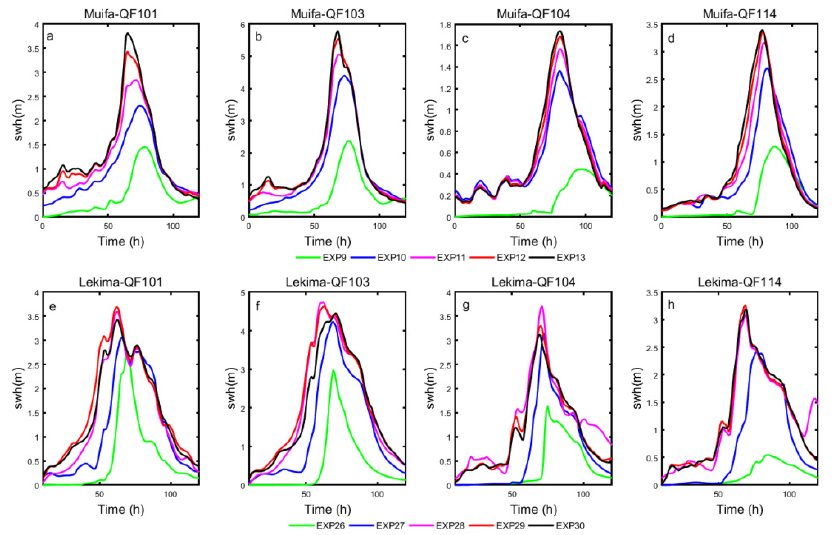
Figure 12. Significant wave height associated with RMW over time at ( a ) QF101, ( b ) QF103, ( c ) QF104, and ( d ) QF114 for Typhoon Muifa and ( e ) QF101, ( f ) QF103, ( g ) QF104, and ( h ) QF114 for Typhoon Lekima.